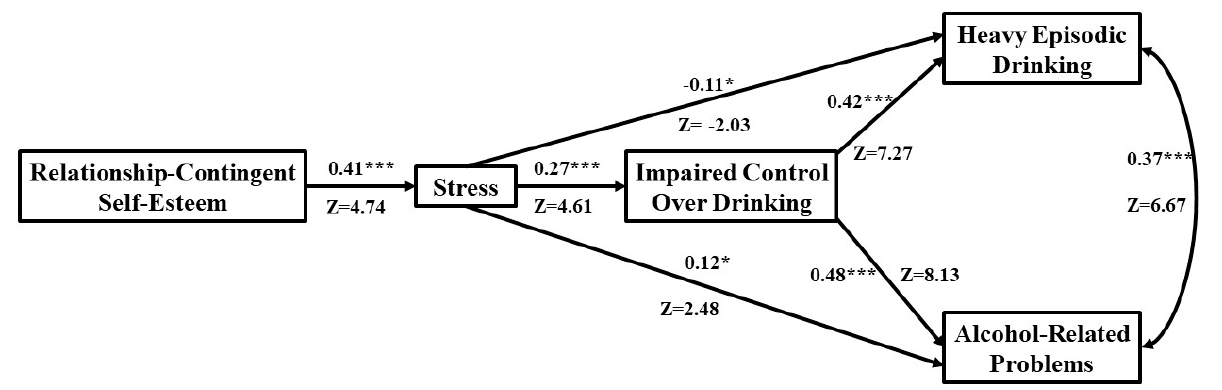
Figure 3. Fit path model for men, N = 286. Standardized coefficients are shown for men: * p < 0.05; *** p <